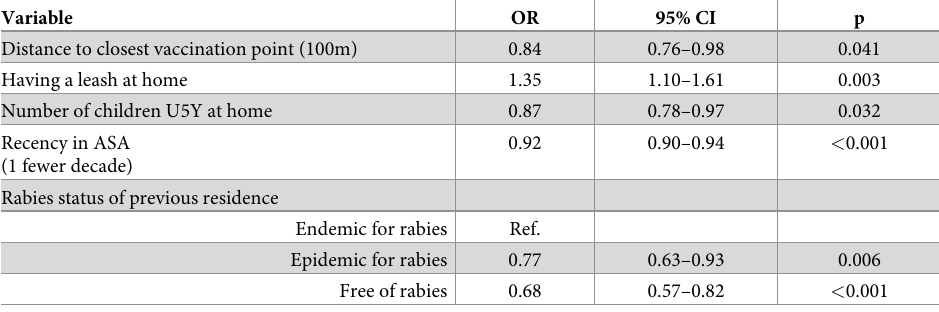
Odds ratios estimated with multiple proportional odds logistic